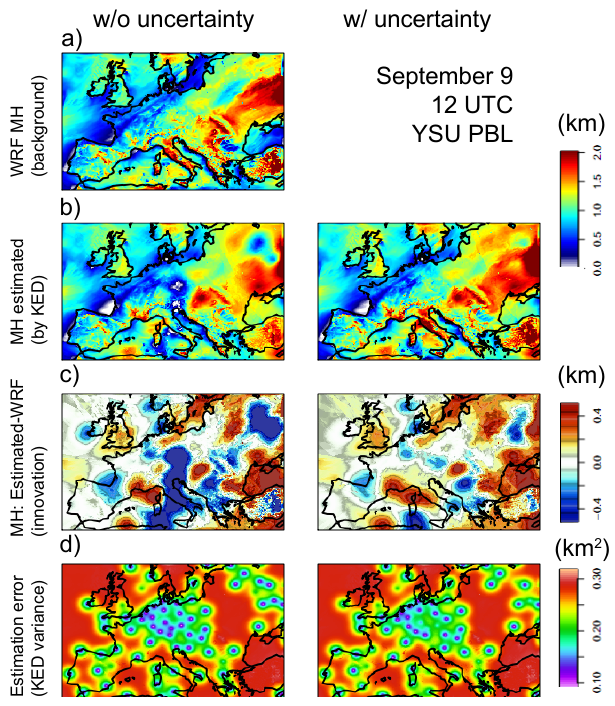
Figure 5. Example of the KED estimation. Shown are the MHs pro- duced by the WRF YSU simulation (a) for each 10 × 10km 2 pixel of the simulation domain on the 9 September 2009, 12:00UTC used as external drift (background field) in the KED estimation. The maps in (b, c, d) (left column) show estimation results neglecting uncer- tainty of observed MH in the KED estimation and the right col- umn the results when accounting for this uncertainty. The KED op- timized MHs are shown in row (b) . The innovation for each pixel is computed as the difference of optimized MH and background field (row c ). Also shown in row (d) is the resulting KED error variance. Less error variance is observed near the locations of